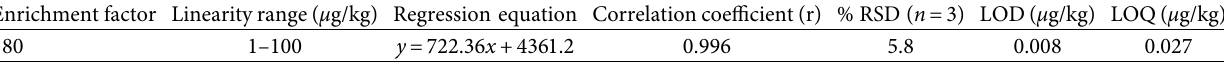
Figure 10: Effect of the desorption solvent on desorption efficiency. Extraction time 20min, desorption time 25min, and sample volume 5mL; no adjustment of sample pH. Table 1: Quantitative data: enrichment factor, linearity, regression equation, correlation coefficient ( r ), repeatability (% RSD, n � 3), LOD (S/N � 3), and LOQ (S/N �